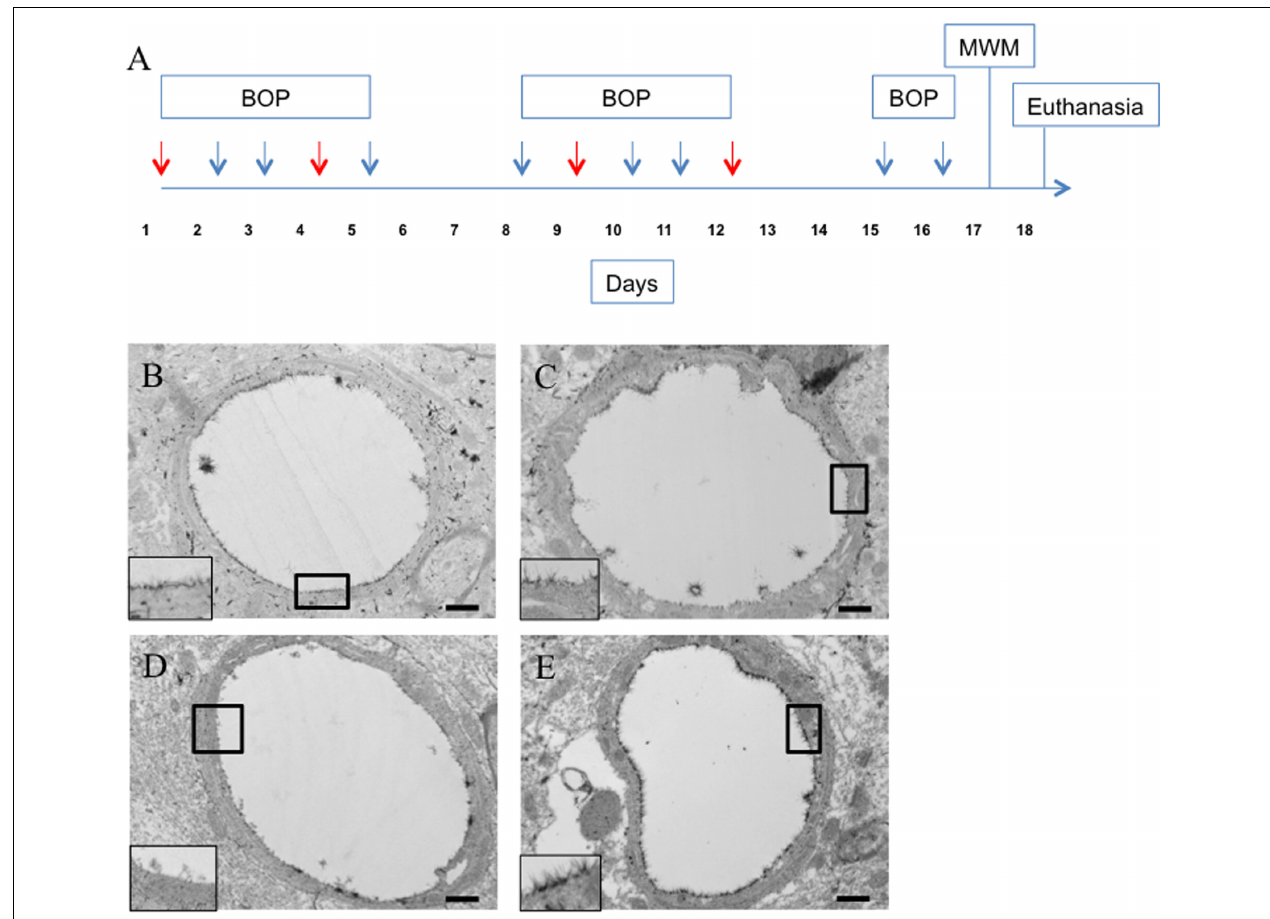
FIGURE 4 | Hyaluronidase infusion increased glycocalyx thickness in sham and blasted rats. Schema representing experimental design for experiment 2 (A) . Each arrow represents an individual blast overpressure exposure (BOP) with red arrows denoting days with hyaluronidase infusion. Representative electron micrographs of capillaries from cerebral cortex taken from blast and sham blasted animals infused with hyaluronidase or vehicle. Capillaries from hyaluronidase infused sham controls (C) and blast exposed (E) rats had qualitatively thicker glycocalyx when compared to saline infused sham controls (B) or blast exposed (D) animals. All insets represent magnified image; scale bar = 500